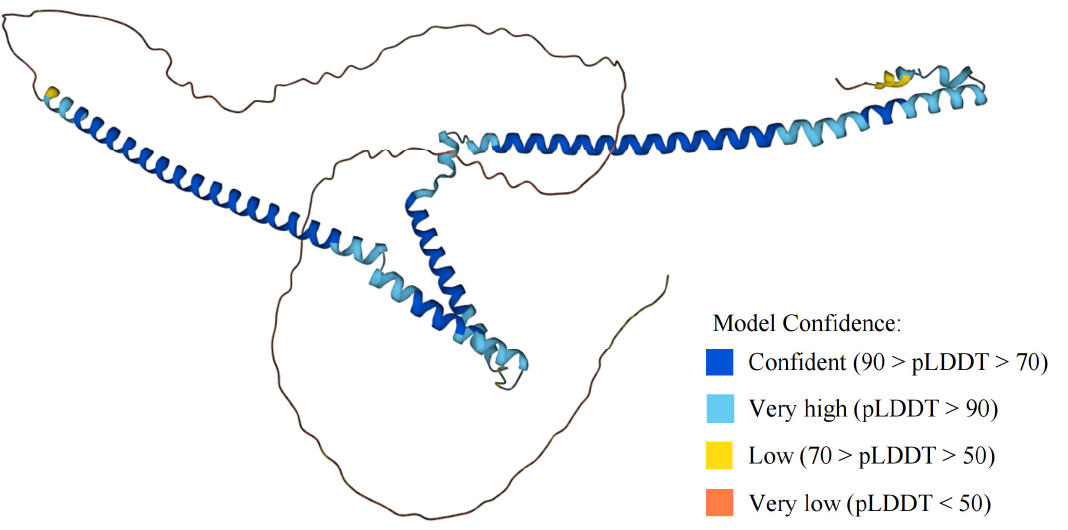
Figure 3. Structural model of WTAP protein in AlphaFold protein structure website. The AlphaFold protein structure website generates a per-residue confidence score (pLDDT) ranging from 0 to 100.